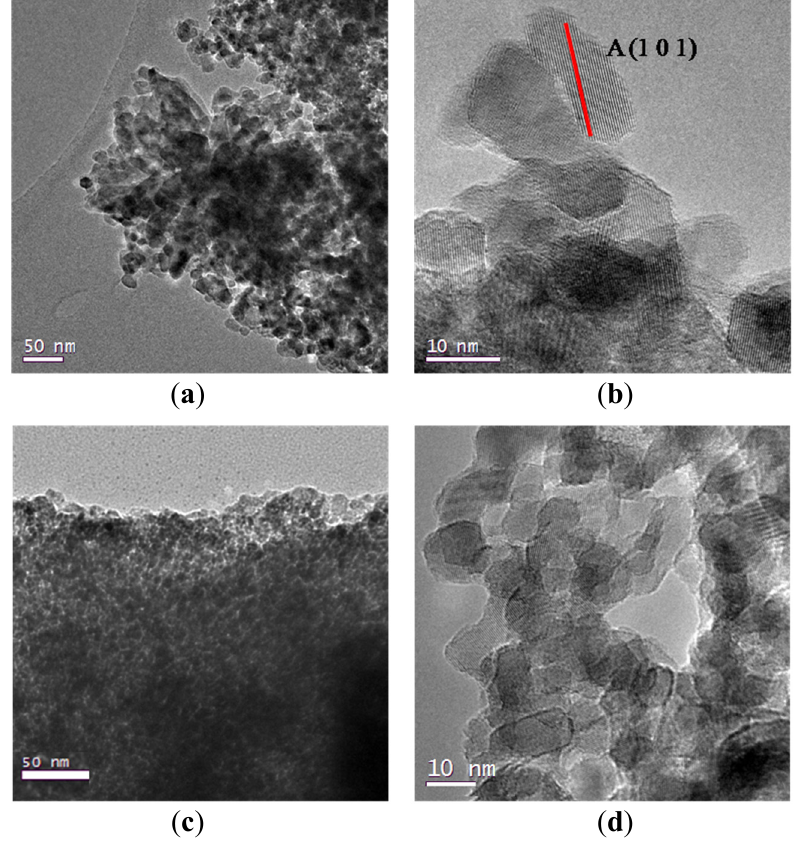
Figure 2. ( a ) TEM images of sample 2; ( b ) detail at high resolutions for sample 2; ( c ) TEM image of sample 3; ( d ) detail at high resolution for samples